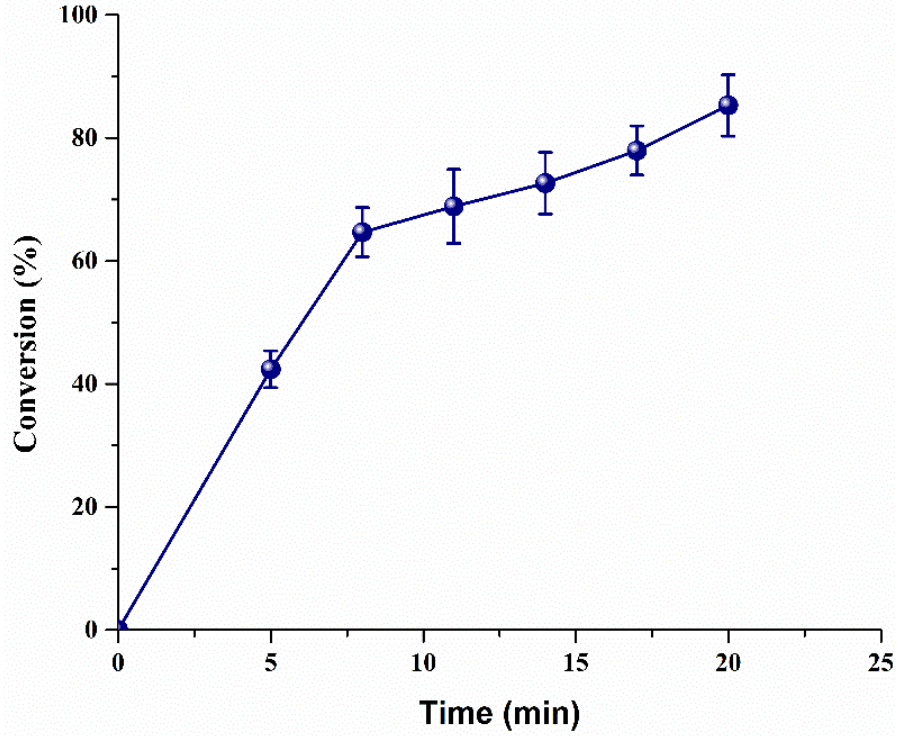
Figure 6. Biodiesel production over time using microbubble technology.